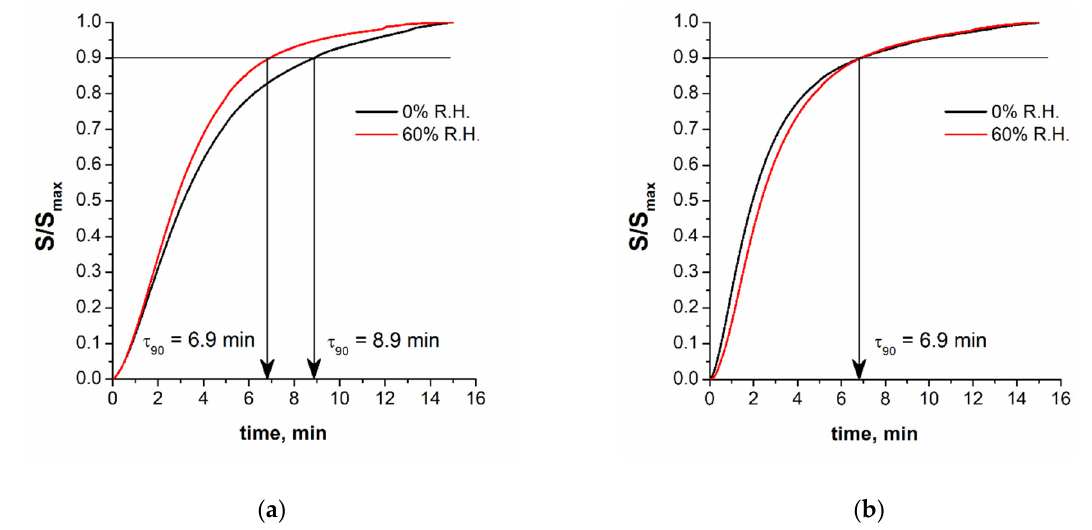
Figure 15. Sensor response time τ 90 in dry and humid air for: ( a ) Co 3 O 4 ; ( b ) Ni 0.1 Co 2.9 O 4 .